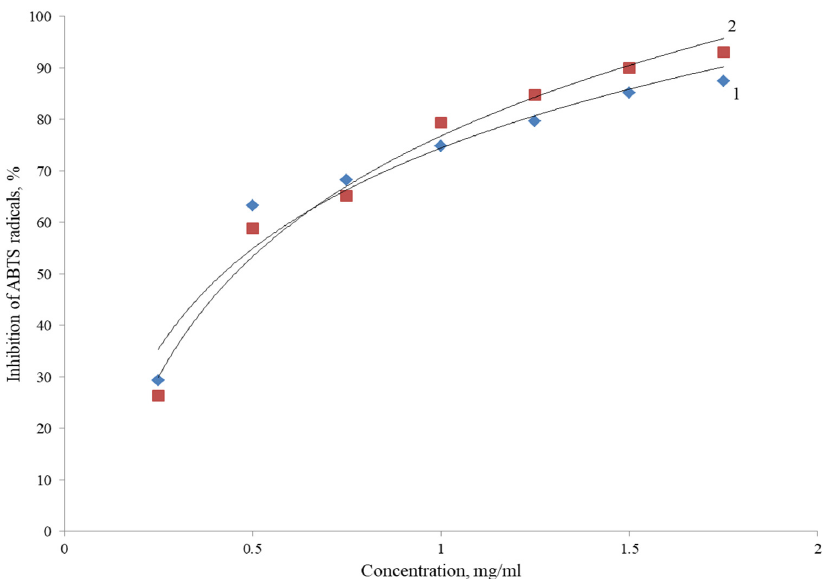
Figure 8. Effect of Amelanchier ovalis berry extract on antiradical activity: 1— Amelanchier ovalis extract (y 1 = 28.189ln(x) + 74.44); 2—ascorbic acid (y 2 = 33.805ln(x) + 76.782). Table 2. Antioxidant activity of the dry Amelanchier ovalis berry extract.